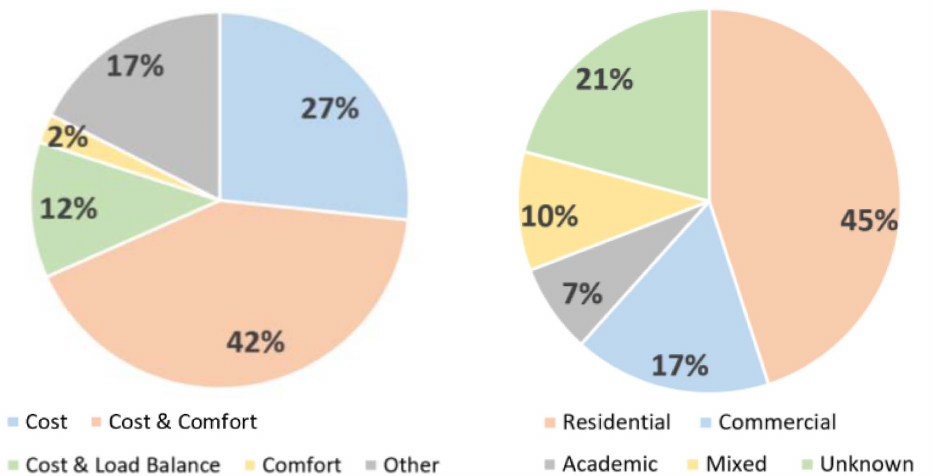
Figure 15. Objectives and Building Types. Proportions of articles in each objective ( left ) and building type ( right ).